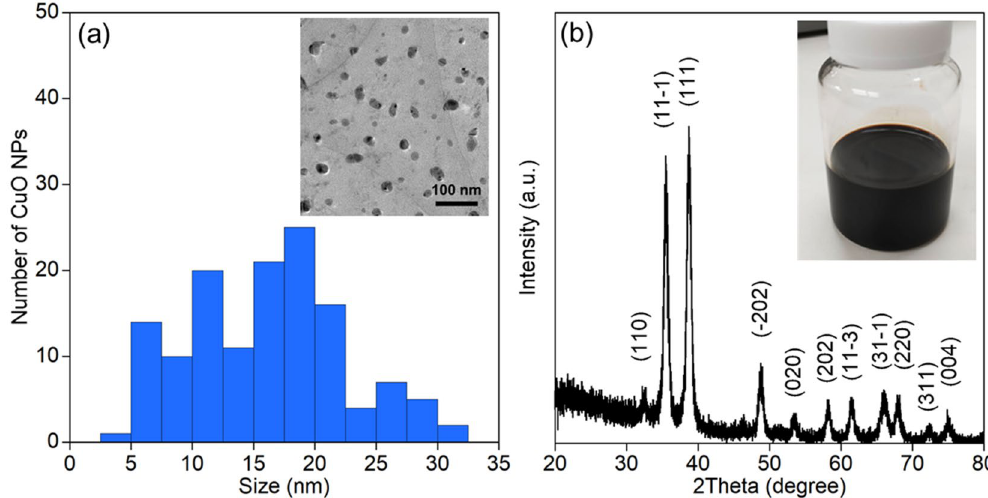
Fig. 2 a Size distribution diagram of the as-prepared CuO NPs. Inset shows the TEM image of the as-prepared CuO NPs. The scale bar length is 50 nm. b XRD pattern of the as-prepared CuO NPs. The inset shows a photograph of the as-prepared CuO NPs ink